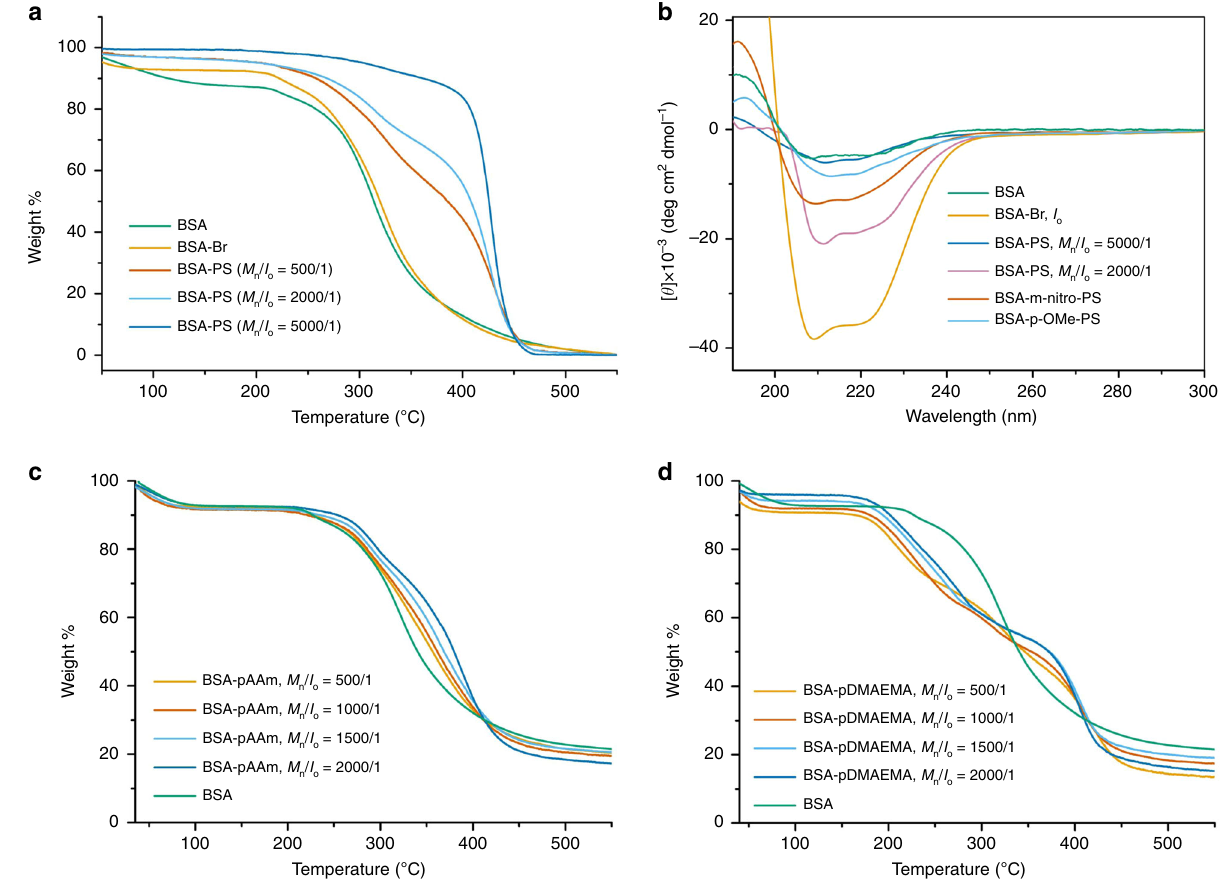
Fig. 3 Structural characterization of BSA-polymer bioconjugates. a Thermograms of BSA, BSA-Br, and BSA-PS conjugates (N 2 atmosphere). b CD spectra of BSA, BSA-Br (I o ), and BSA-polymer conjugates. ( c ) Thermograms of BSA, BSA-Br, and BSA-PAAm conjugates (N 2 atmosphere). d Thermograms of BSA, BSA-Br, and BSA-PDMAEMA conjugates (N 2